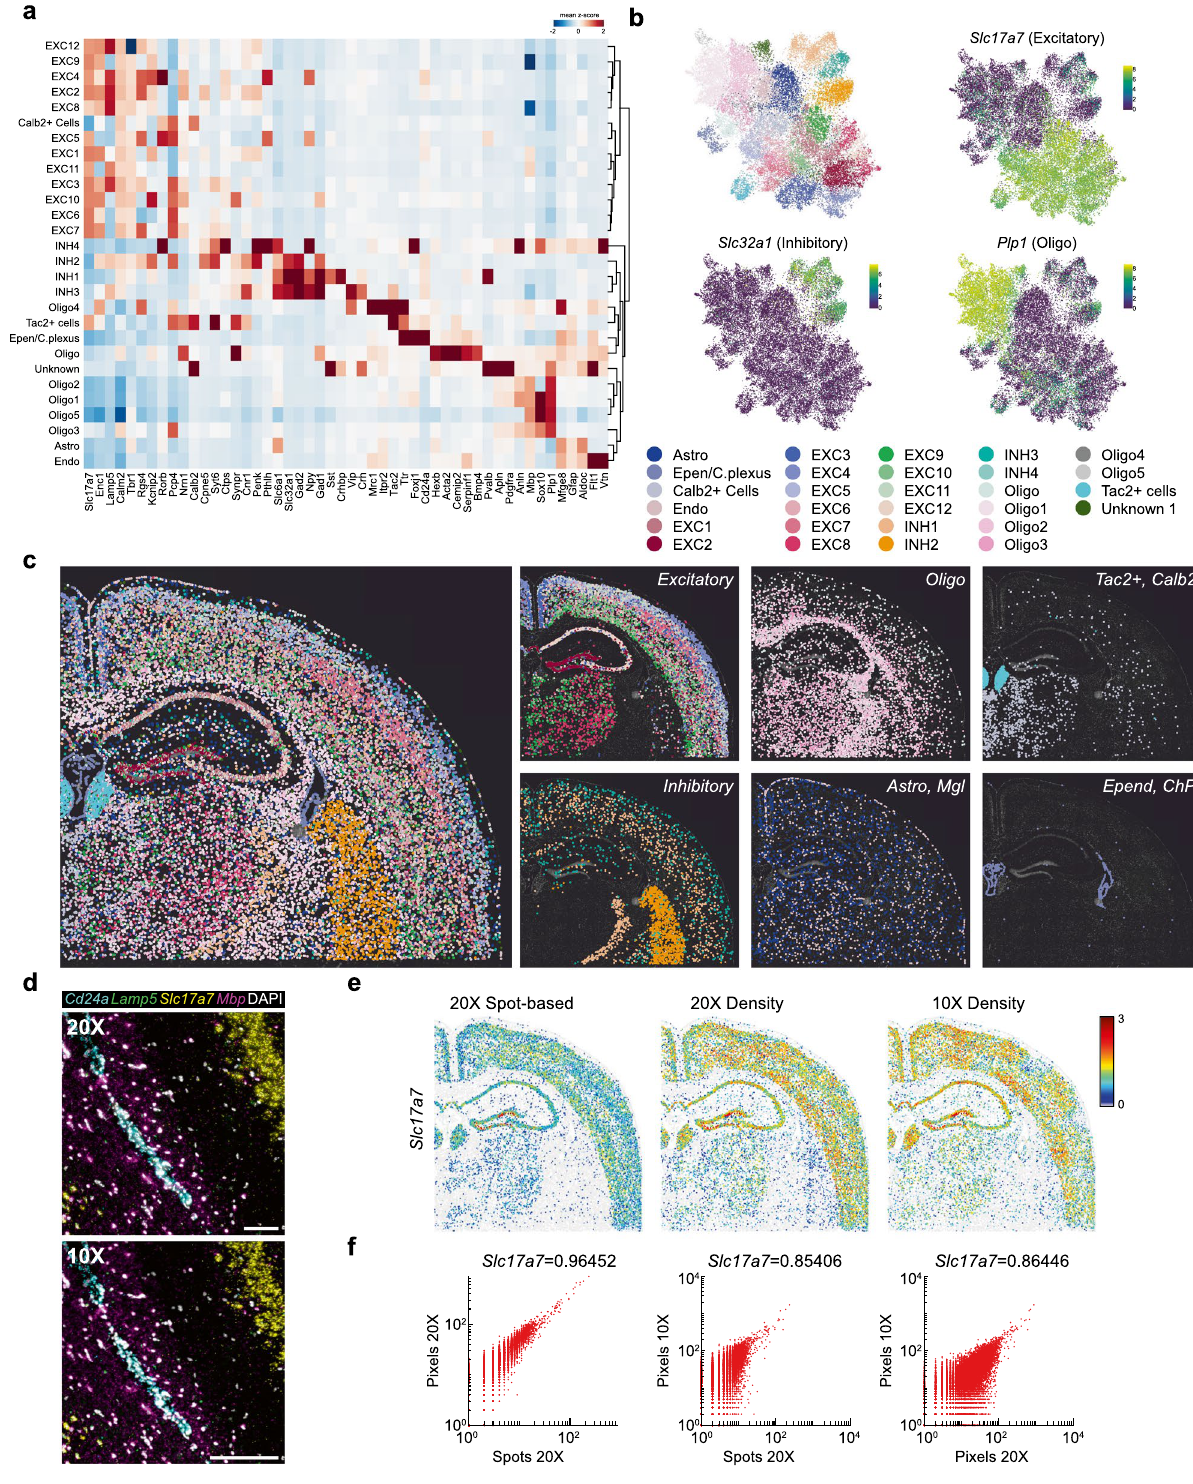
Figure 2. De novo clustering of 50 gene expression in mouse brain coronal section. ( a ) Expression matrix of 50 targeted genes across annotated cell clusters in segmented cells of the imaged region. ( b ) Uniform Manifold Approximation and Projection (UMAP) with de novo cell clustering based on the expression profile of the 50-plex gene panel. Three genes highlighted for their expression to mark pan-excitatory neurons ( Slc17a7 ), inhibitory neurons ( Slc32a1 ), and oligodendrocytes ( Plp1 ). ( c ) Cell-type map across mouse coronal section, highlighting some classes in right panels. ( d ) Raw image comparison of 20X and 10X objective imaging. 200 pixel scale bar, 20X = 64.2 µm, 10X = 128.4 µm. ( e ) 20X objective spot-based detection converted to density- based detection compared to 10X objective density-base detection for Slc17a7 . ( f ) Correlation comparison of 20X spot- and density-based detection to 10X-density based